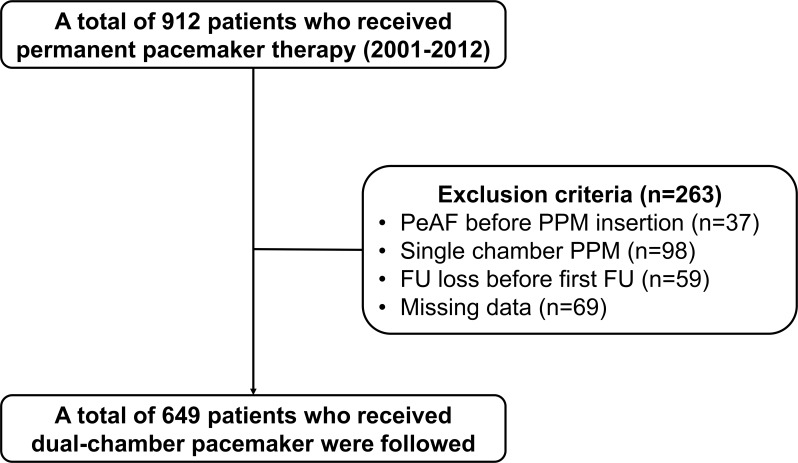
Flow diagram of study patients.